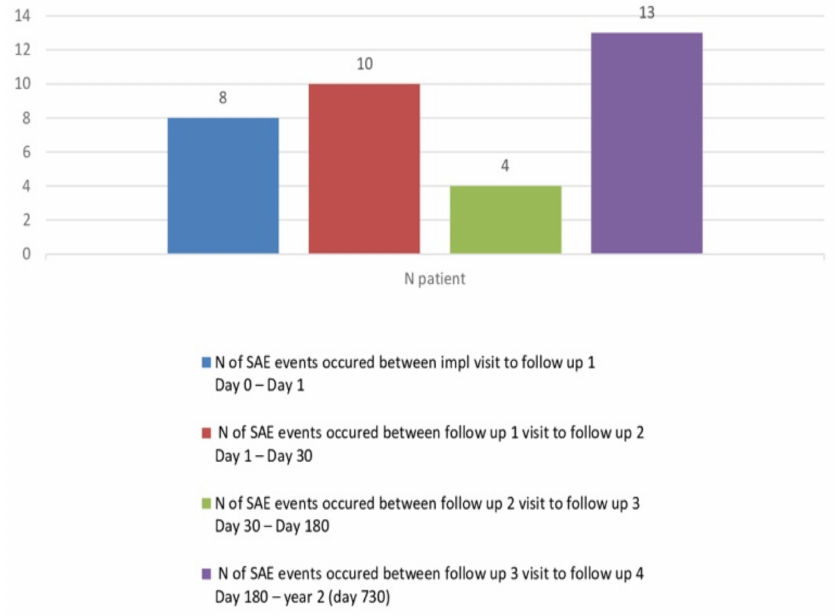
Figure 5. Number of SAE events occurred between visits